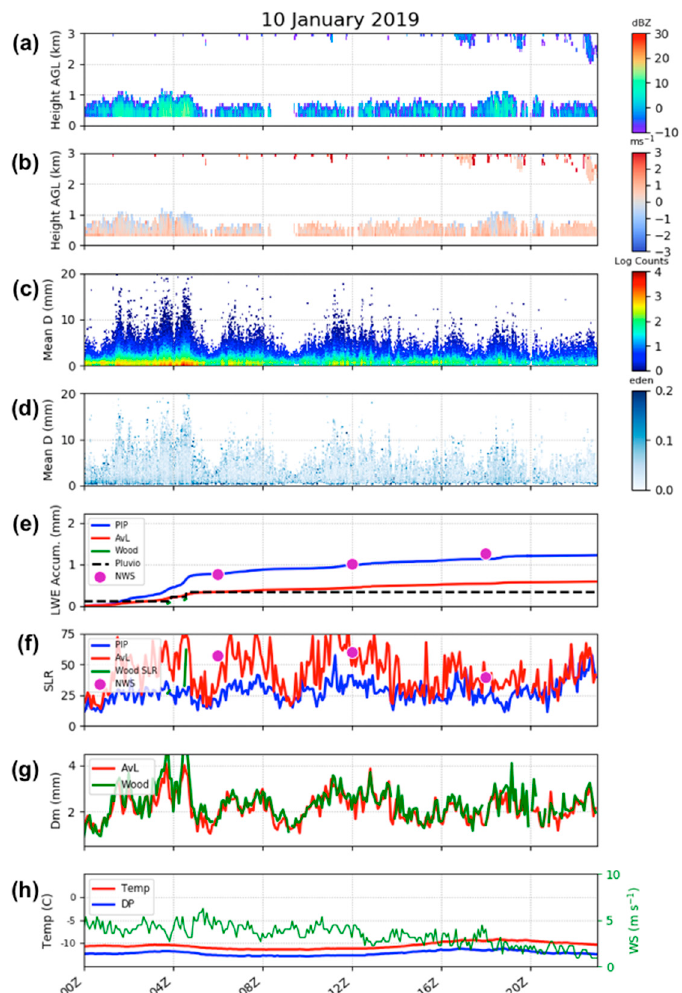
Figure A2. Example of a high SLR snow event on 10 January 2019. ( a ) Shown is data from the MRR reflectivity, ( b ) MRR Doppler velocity, ( c ) PIP-produced PSDs, ( d ) PIP-derived ρ e distribution as a function of D e , ( e ) LWE accumulation for all three retrievals, the Pluvio, and the NWS 6-hourly snow field, ( f ) calculated SLR from all three retrievals and the NWS 6-hourly snow field observations, ( g ) the mass-weighted diameter ( D m ) from von Lerber and Wood, ( h ) and the surface meteorological conditions. All variables are presented as a function of time from 0000 UTC to 2300 UTC.